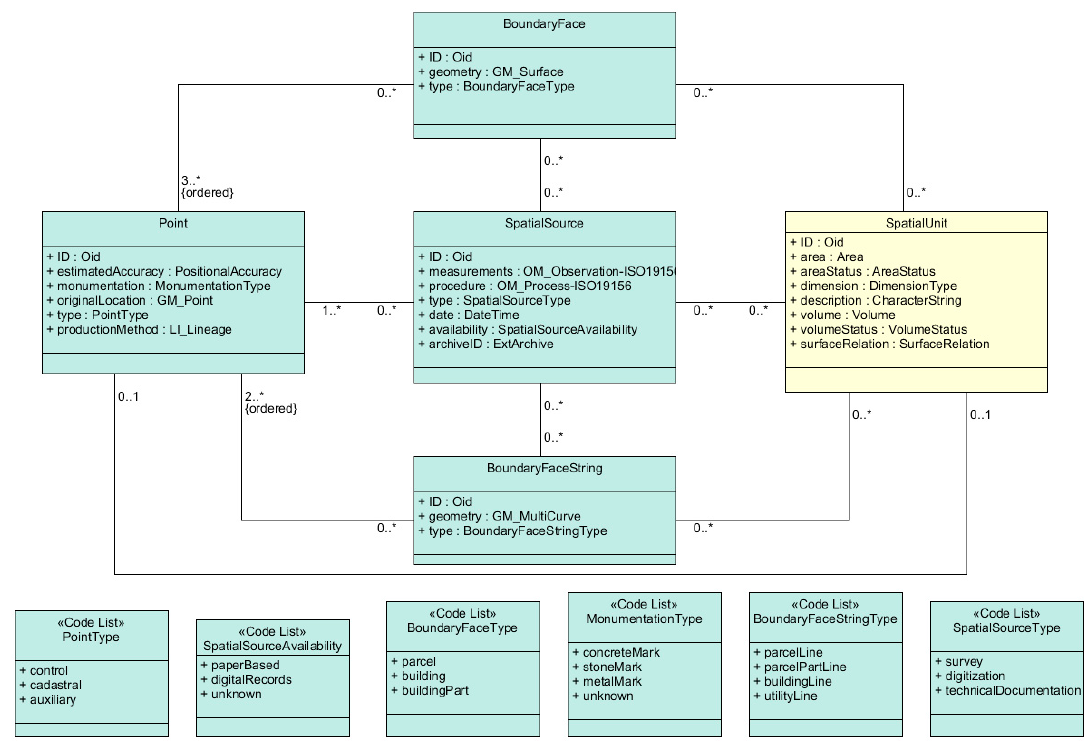
Figure 3. The spatial component of the data model.